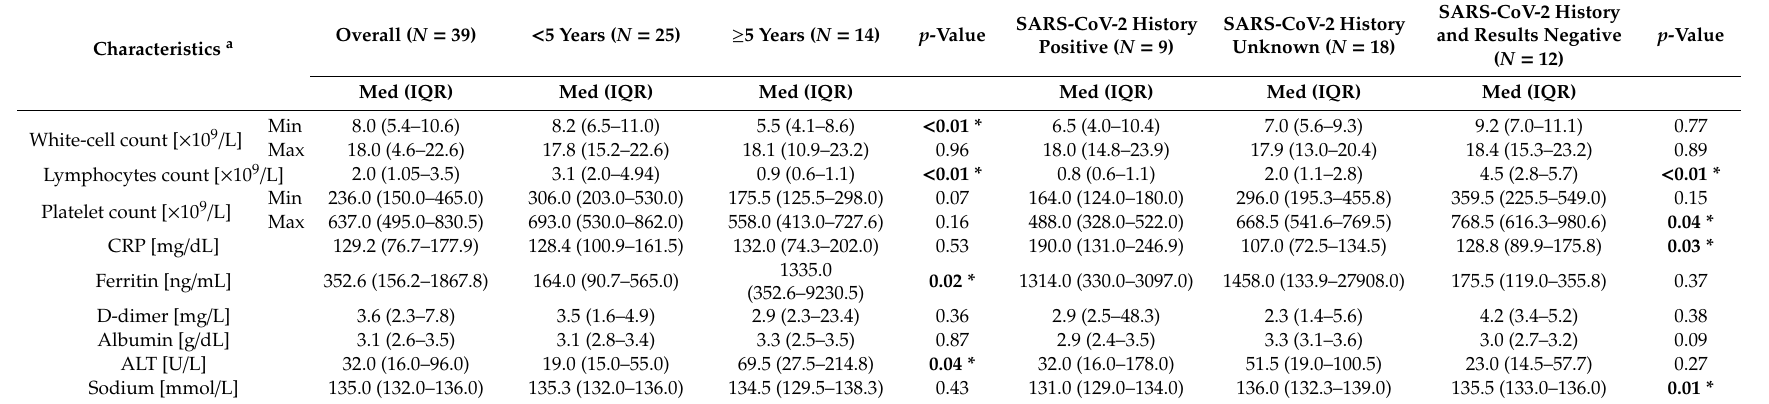
Table 4. Laboratory results, according to age group and SARS-CoV-2